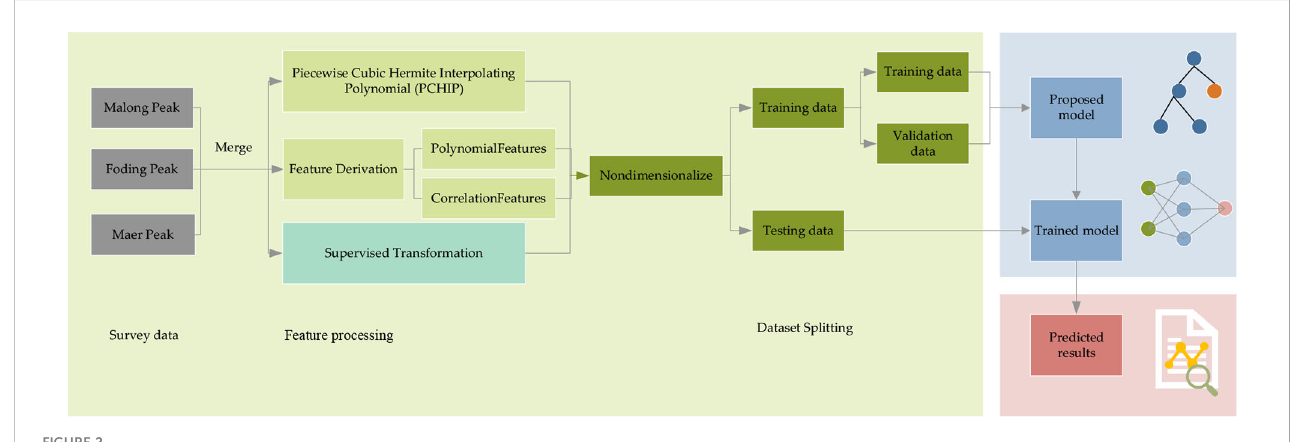
FIGURE 2 The framework of multiple factors crown pro fi le modeling based on deep